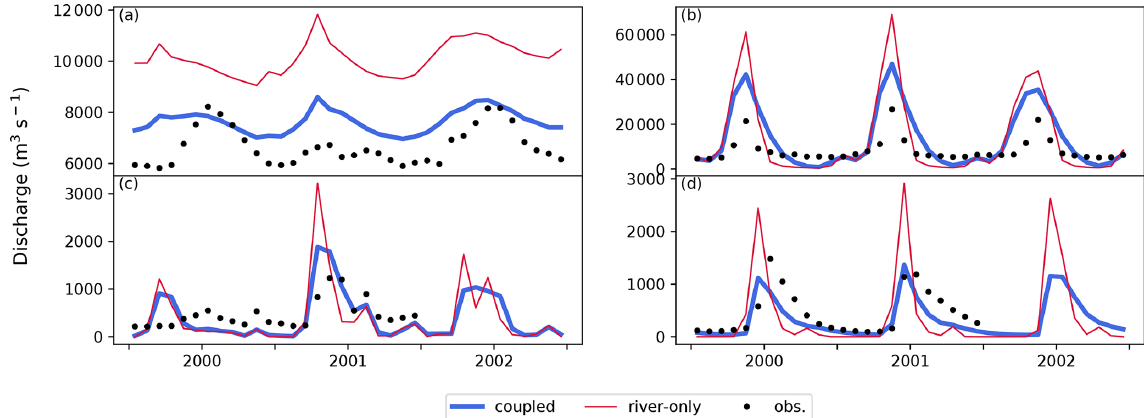
Figure 5. Time series of monthly mean values of river discharge (m 3 s − 1 ) for (a) Cornwall station on the St. Lawrence River, (b) Volgograd station on the Volga River, (c) Manitou Rapids station on the Rainy River, and (d) Above Kazan Falls station on the Kazan River. Black dots show the observed values, and blue (red) lines show values calculated by the coupled (river-only) simulation. The GRDC station codes for these stations are 4143550, 6977100, 4213211, and 4214090,